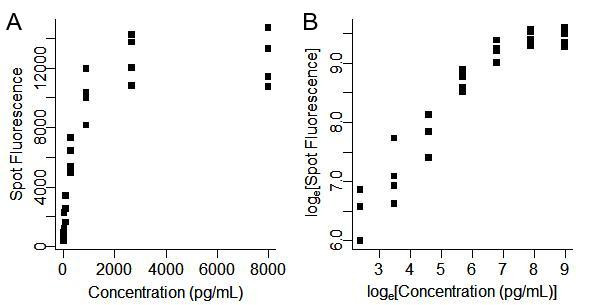
Spot fluorescence and standard concentration A graph of spot fluorescence as a function of standard concentration (A) shows that both the difference in concentration and the variability in spot fluorescence increase with concentration. Both negatively affect model fitting and subsequent statistical inferences due to the excessive leverage of the larger concentrations and the heteroskedasticity of the spot intensities. In this case, loge transforms of both concentration and spot fluorescence reduce the excessive leverage and improve the homogeneity (B). The log transformation is consistent with the featured concentration dilution series and is a common transformation of chemical measurements that often are assumed log normally distributed.